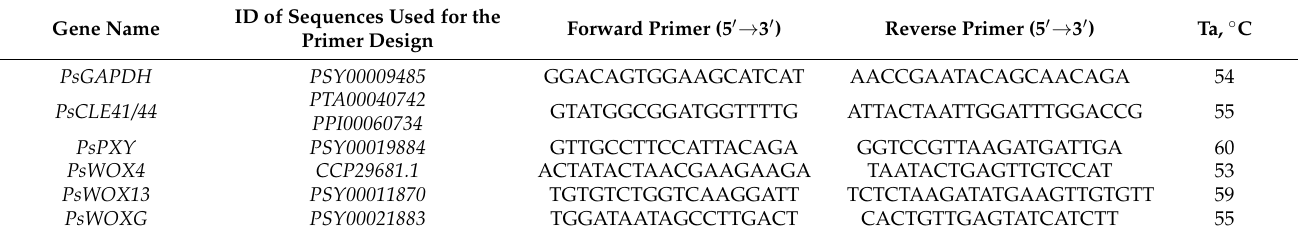
Table 3. List of primers for the RT-PCR